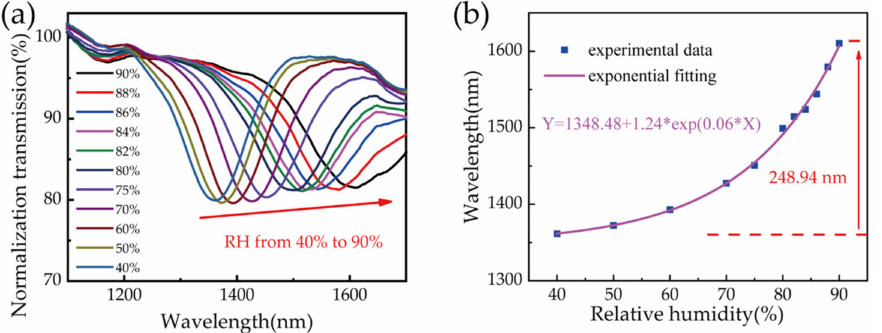
Figure 4. ( a ) Evolution of the transmission spectrum with increasing humidity for sample 3. ( b ) Resonance wavelengths of sample 3 for varying RH values. The purple and blue curves in ( b ) represent exponential and linear fits applied to the experimental data,